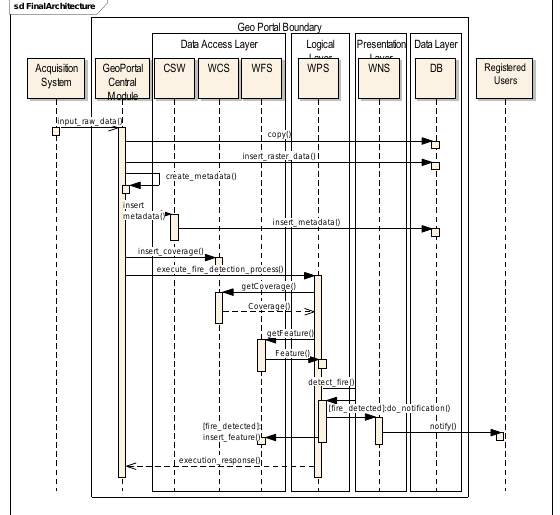
Figure 5. Sequence diagram of proposed architecture